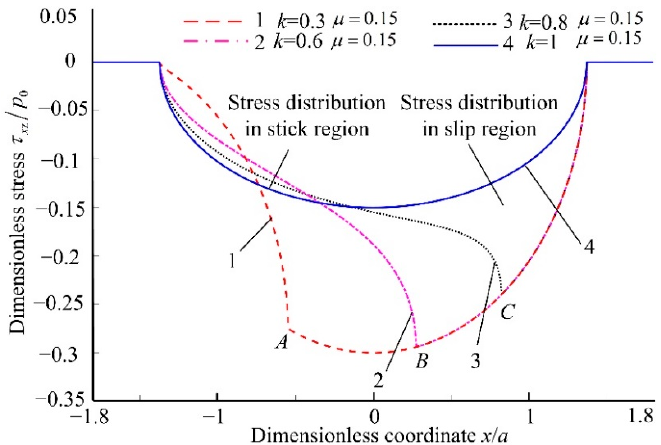
Figure 10. Stress τ xz / p 0 for different values of k.